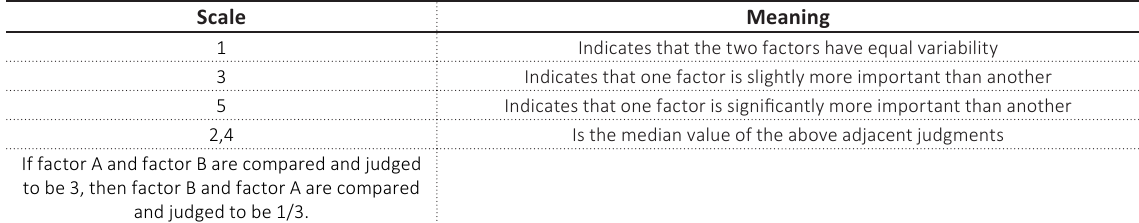
Table 2. Form of relative importance degree Scale